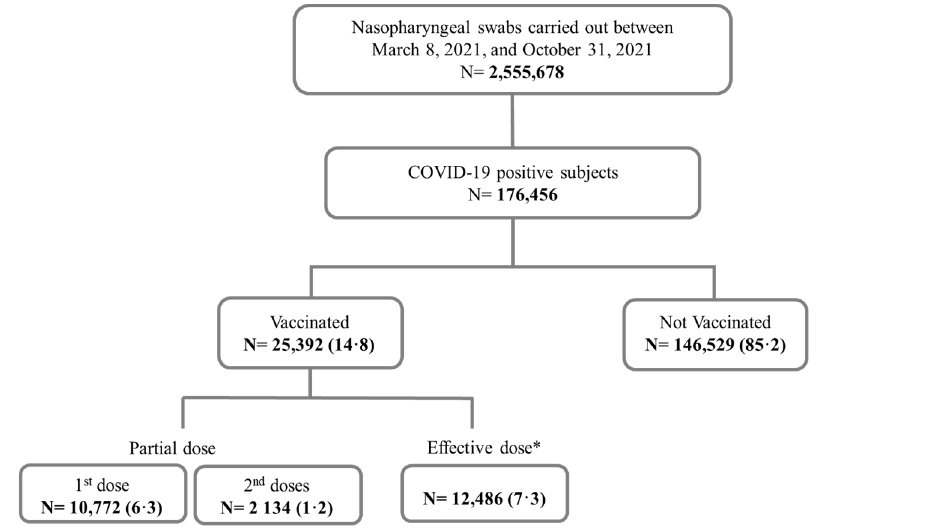
Figure 1. Flow chart: cohort selection.